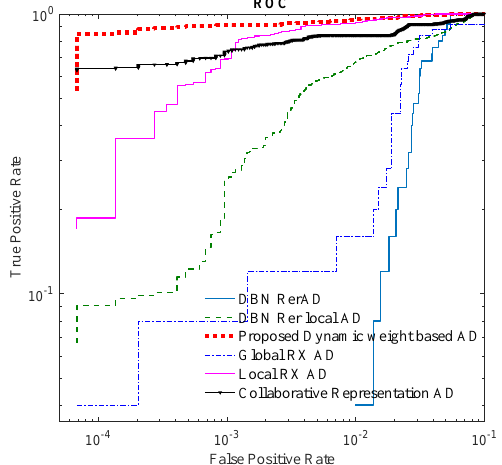
Figure 11. The ROC of Lake Salvador HSI image